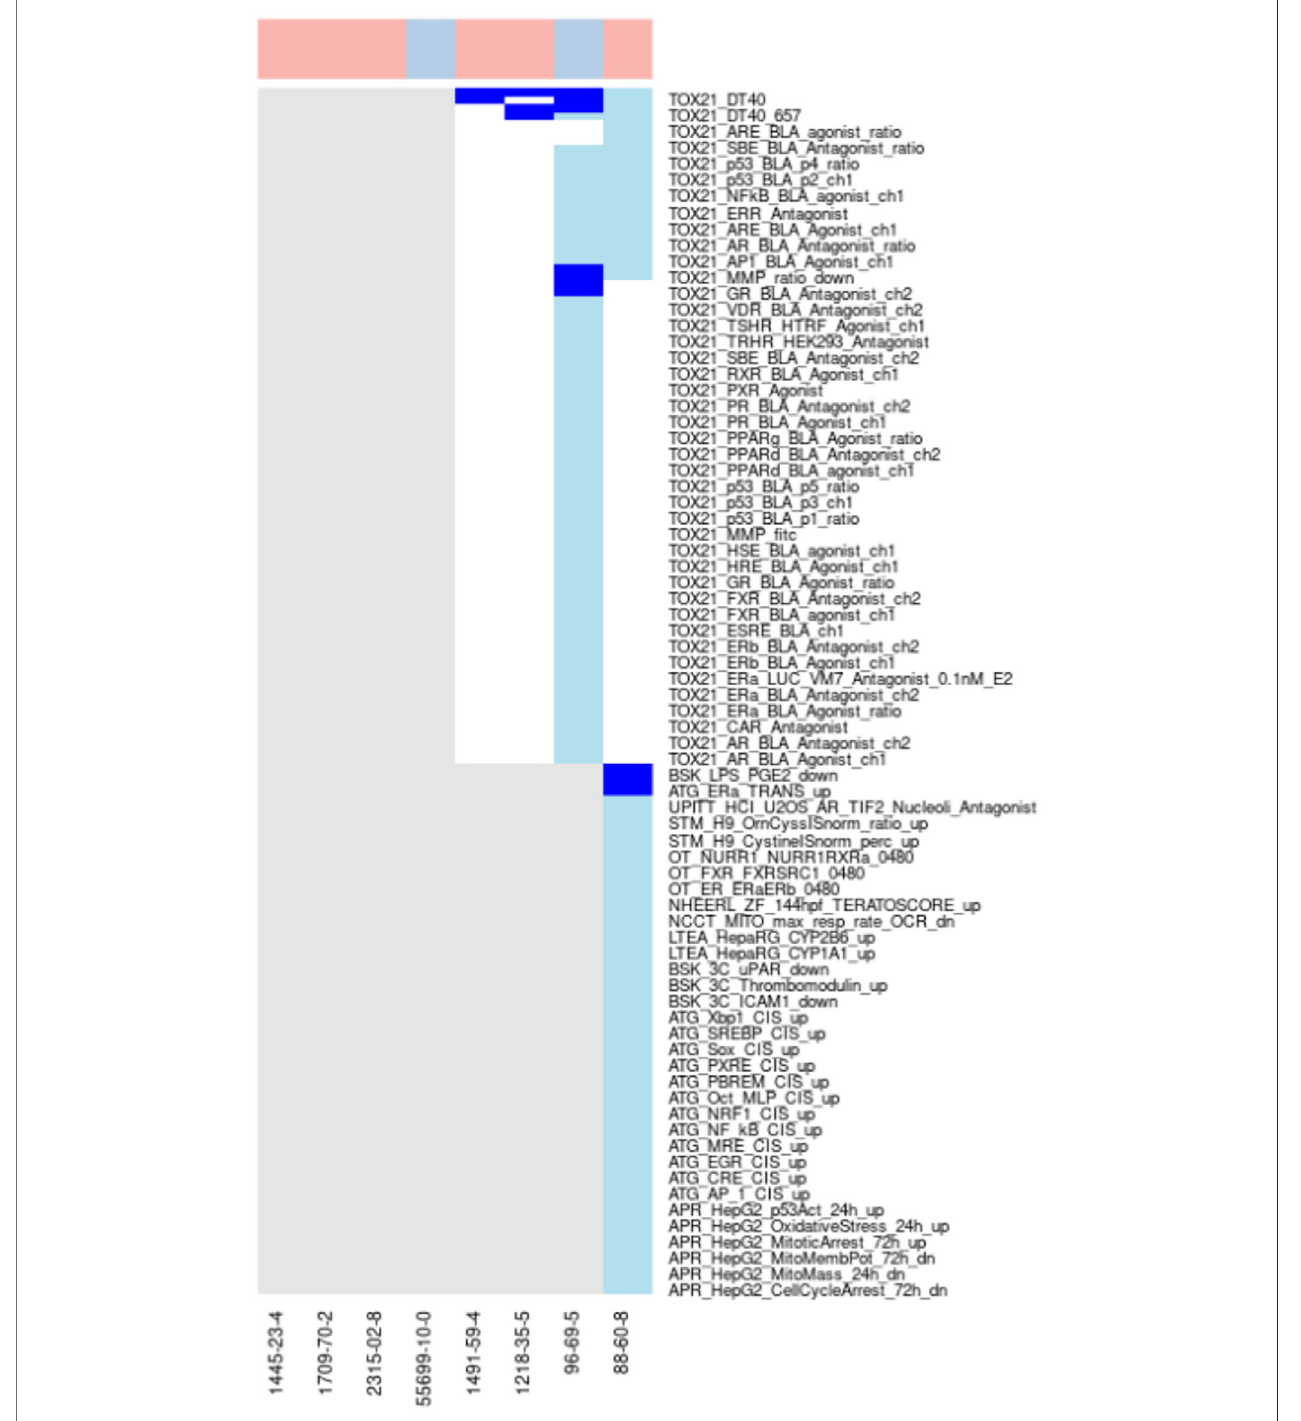
FIGURE10| Adrenergicreceptoragonists.Heatmapshowingactivityforallassayswhereatleastonechemicalfromtheclusterwasactive.Notallassaynamesare shown.Heatmapcolors:blue=activebelowthecytotoxicitypoint,lightblue=activeabovethecytotoxicitypoint,white=inactive,grey=nottested.Topofheatmap:red = toxic, blue = nontoxic, aquamarine = unde fi ned.